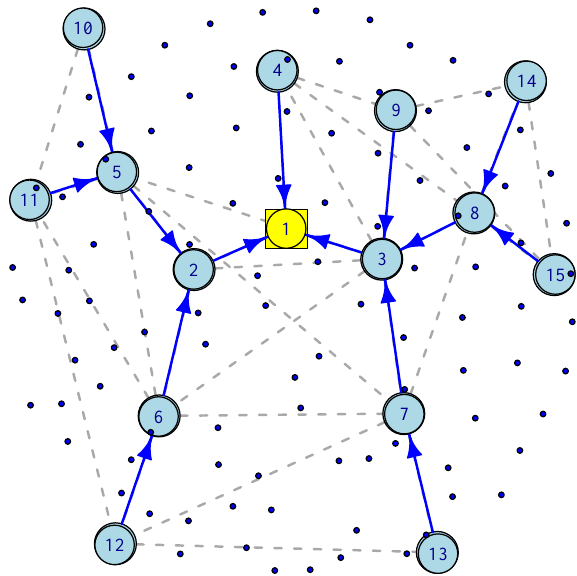
Figure 4. An illustration of Wireless Mesh Sensor